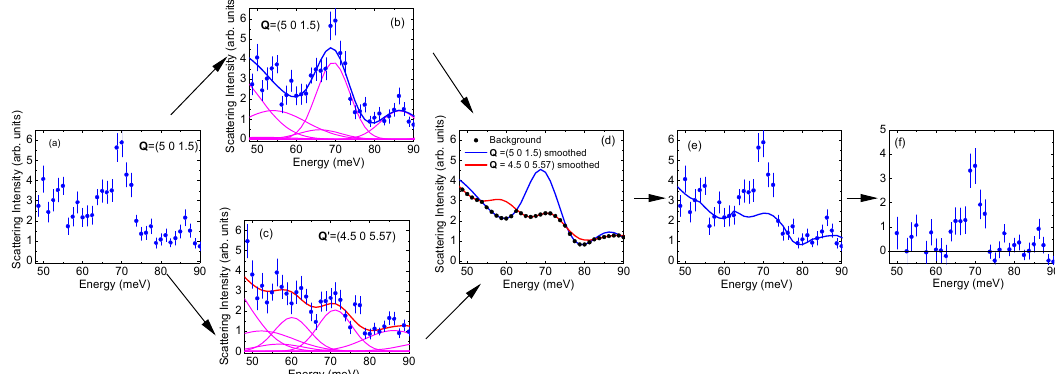
Figure 2. Background subtraction workflow described in the text. ( a ) Raw data; ( b , c ) Raw data with a smooth curve represented by the blue line. Blue line is obtained from fitting to a sum of Gaussian peaks represented by magenta lines; ( d ) Background is the point-by-point minimum of the two smooth curves; ( e ) Raw data with background; ( f ) Background-subtracted data.